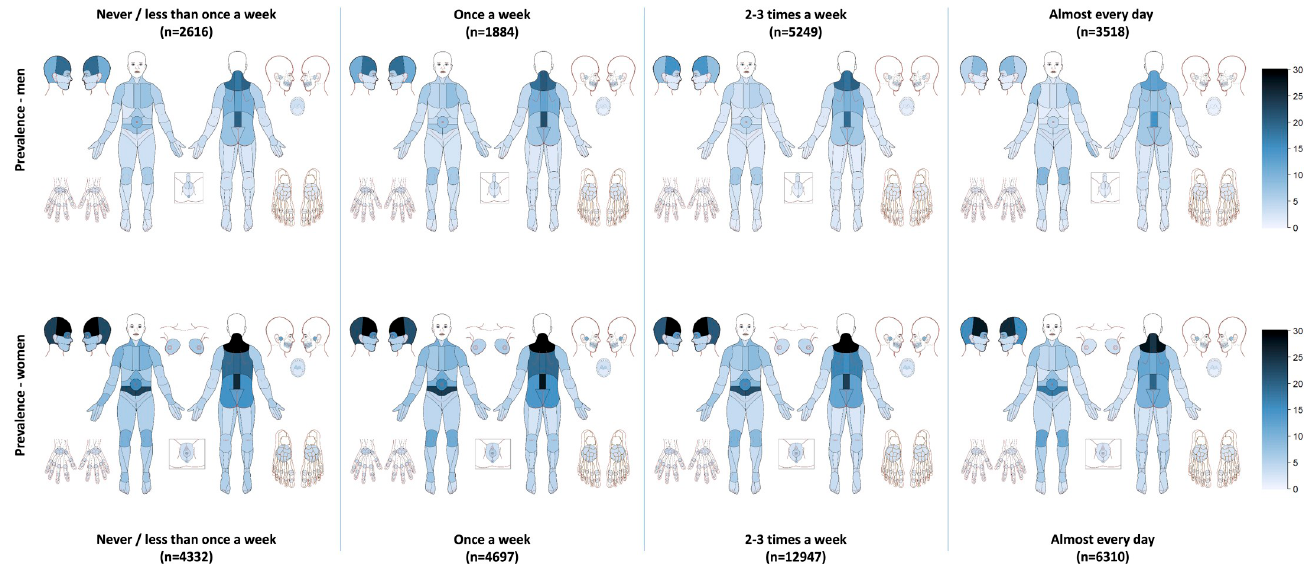
Fig 1. Prevalence and distribution of chronic pain by the average weekly frequency of physical exercise in men and women.